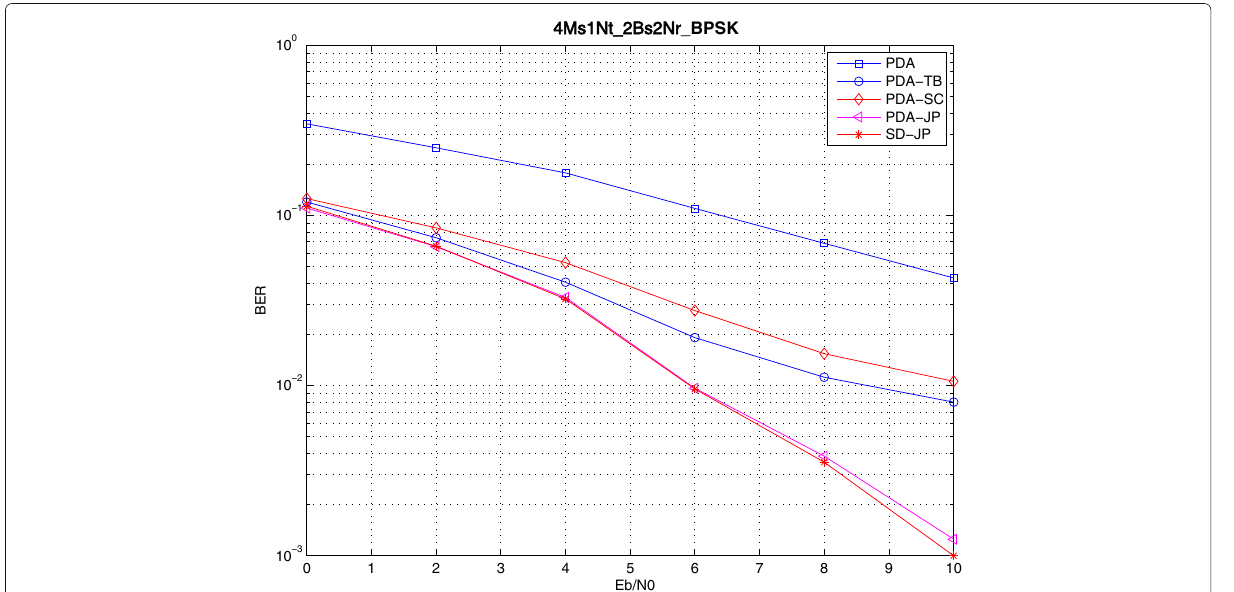
Fig. 4 BER performance with N m = 4 and N r = 2